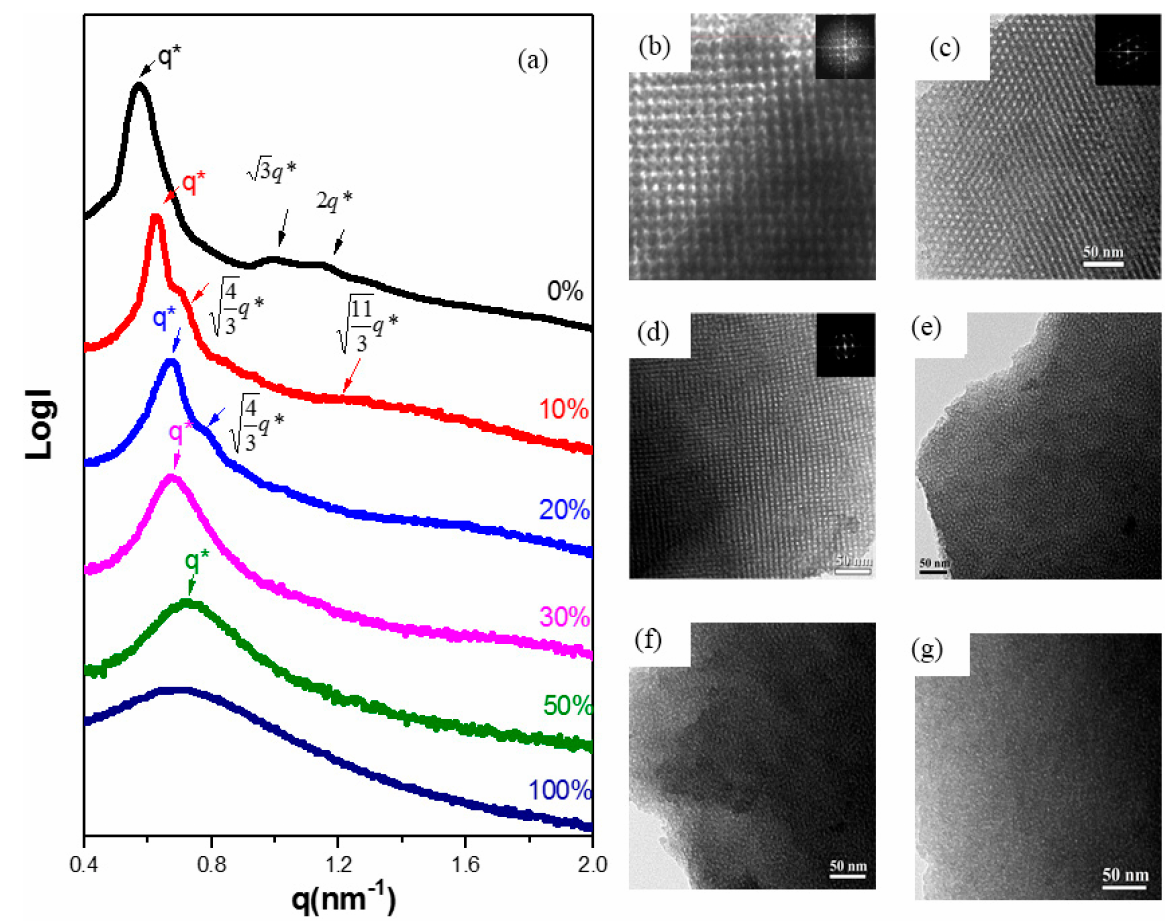
Figure 4. ( a ) Small-angle X-ray scattering (SAXS) and transmission electron microscopy (TEM) images of mesoporous silica samples templated by F127 at various OV-POSS-SILY-to-silica precursor weight ratios of ( b ) 0, ( c ) 10, ( d ) 20, ( e ) 30, ( f ) 50, and ( g ) 100